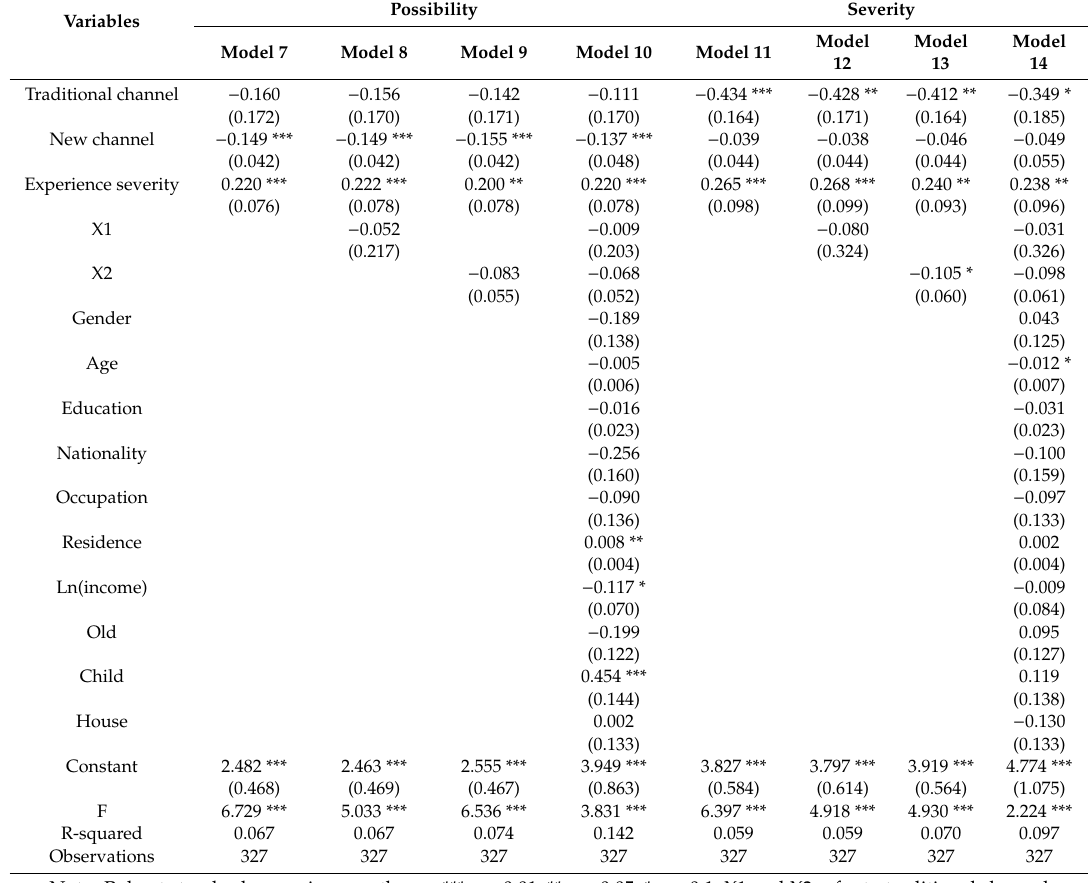
Table 5. Regression analysis results of traditional and new media exposure, disaster experience and perceived prospect ranks of risk